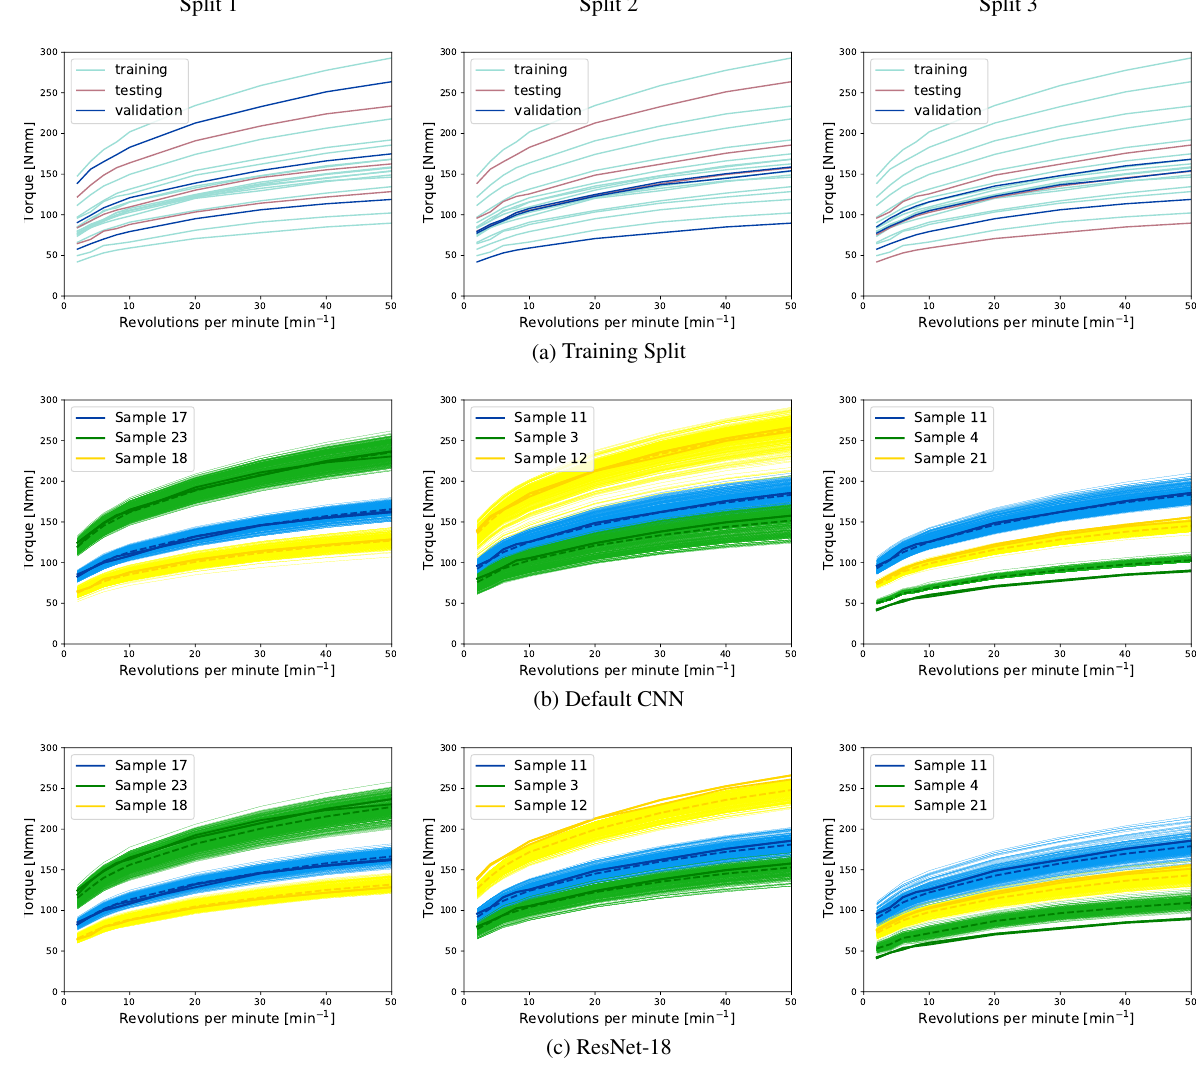
Figure 6. Results for the test sets of 3 different training splits. All predictions of the images belonging to a sample are shown with a thin line in the colour of the respective sample. The thicker dashed lines in the darker colours mark the average prediction values over all test images of a sample. The thicker solid lines in the same colour indicate the reference value (in case two measurements were available, both are